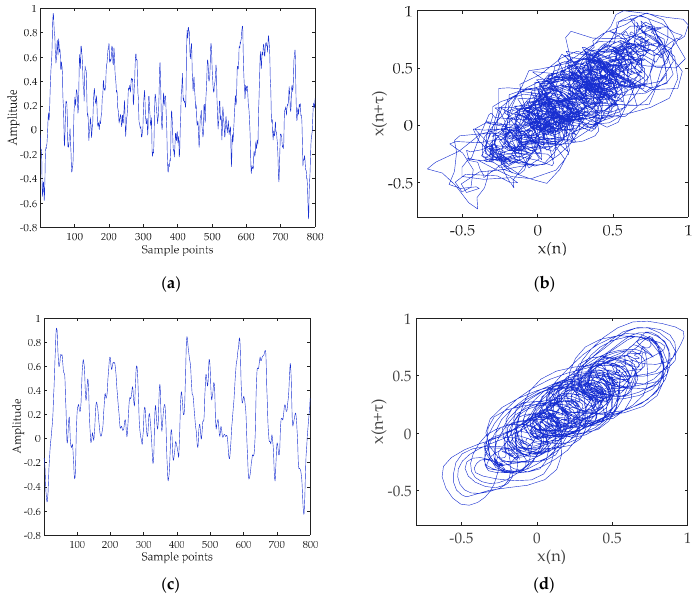
Figure 12. Ship-I and denoised Ship-I signals and their attractor trajectories. ( a ) Ship-I (select 800 points); ( b ) attractor trajectory for Ship-I; ( c ) denoised Ship-I (select 800 points); and ( d ) attractor trajectory for denoised Ship-I.